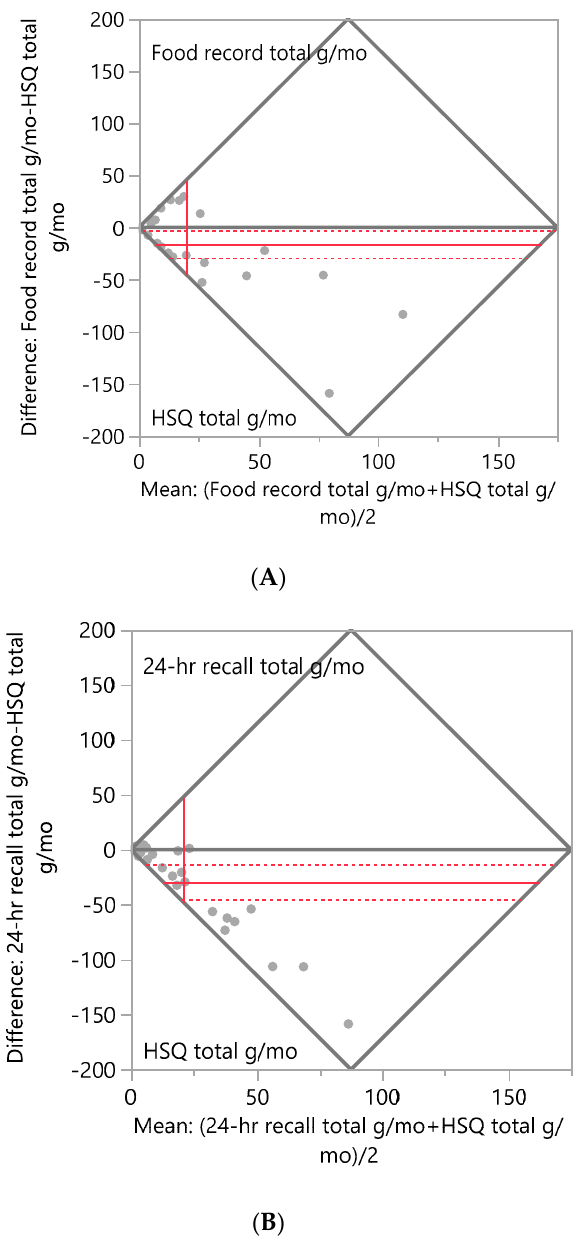
Figure 2. Bland–Altman Plots of the total grams of herbs and spices consumed per month. ( A ) Difference in total g/mo of herbs and spices consumed between the Herb/Spice Questionnaire (HSQ) and food records. N = 33 respondents; mean difference between methods = − 15.8, Wilcoxon signed rank test, p < 0.05. ( B ) Difference in total g/mo of herbs and spices consumed between the HSQ and 24-h recalls. N = 29 respondents; mean difference between methods = − 29.2, Wilcoxon signed rank test, p < 0.001. The mean difference is shown as the horizontal solid red line, with the 95% confidence interval above and below shown as red dotted lines. The mean of pairs is shown by the vertical red line.